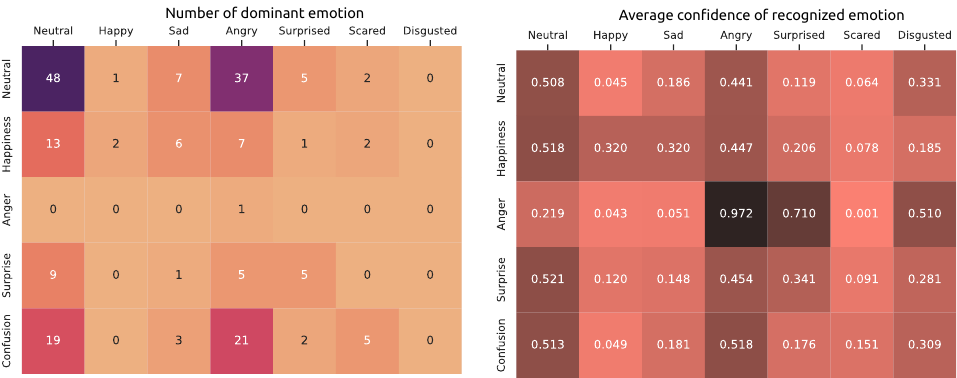
Figure 3. Confusion matrices of annotated labels and FaceReader analysis